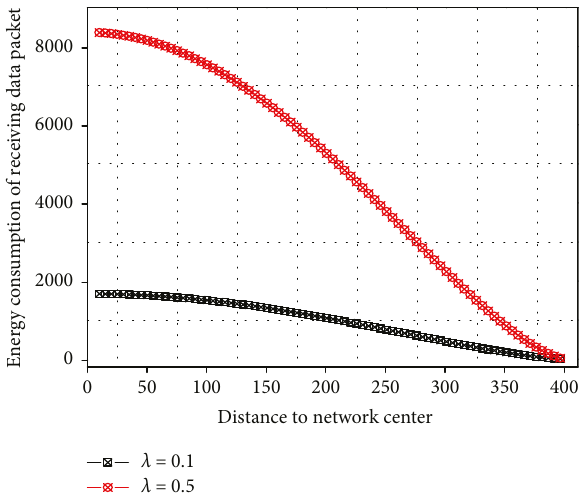
Figure 15: The energy consumption of nodes receiving data packets in di ff erent areas.